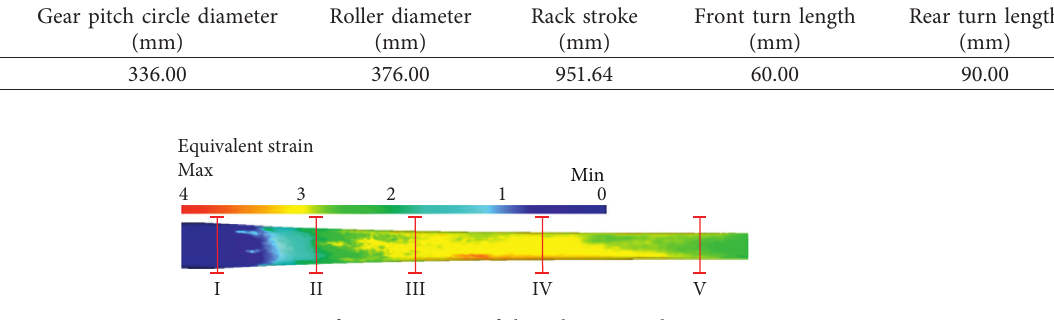
Figure 7: Deformation zone of the tube in simulation.